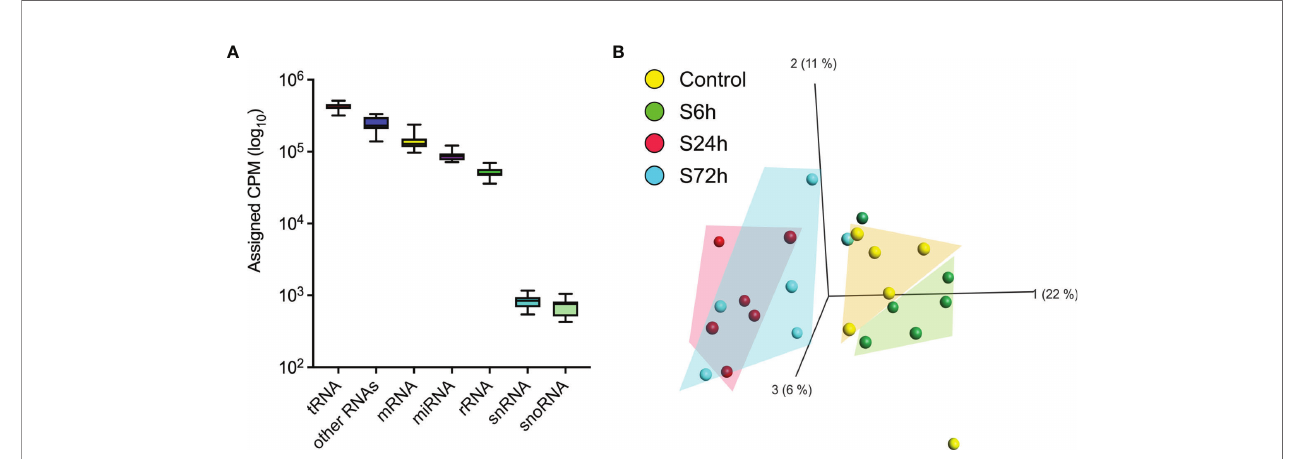
FIGURE 5 | RNA mapping and miRNA PCA. (A) The averaged RNA-seq data from the control samples were used to map RNA categories [sRNAbench webserver (19)]. (B) Principal component analysis of the circulating EVs ’ miRNA data. Normalized miRNA read counts [Counts Per Million reads (CPM)] were log2-transformed and used by Qlucore software to create a PCA plot. 24 h and 72 h post-surgery groups cluster together and are separated from the control whereas the 6 h group clusters with the control.